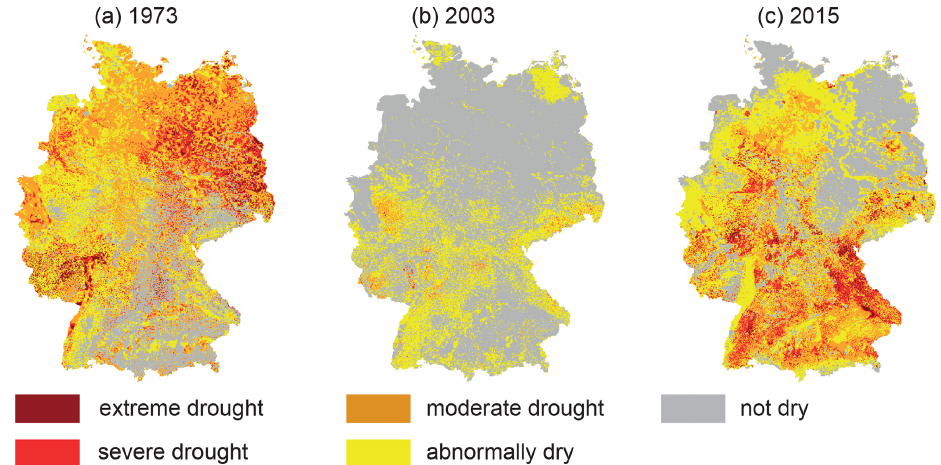
Figure 3. Modelled groundwater drought situation during summer months (JJA) for benchmark drought events. Drought classes are derived from average standardized water table referring to the thresholds − 2 (2.3% of time: extreme drought), − 1 . 5 (6.7% of time: severe drought), − 1 (15.9% of time: moderate drought) and 0 (50% of time: abnormally